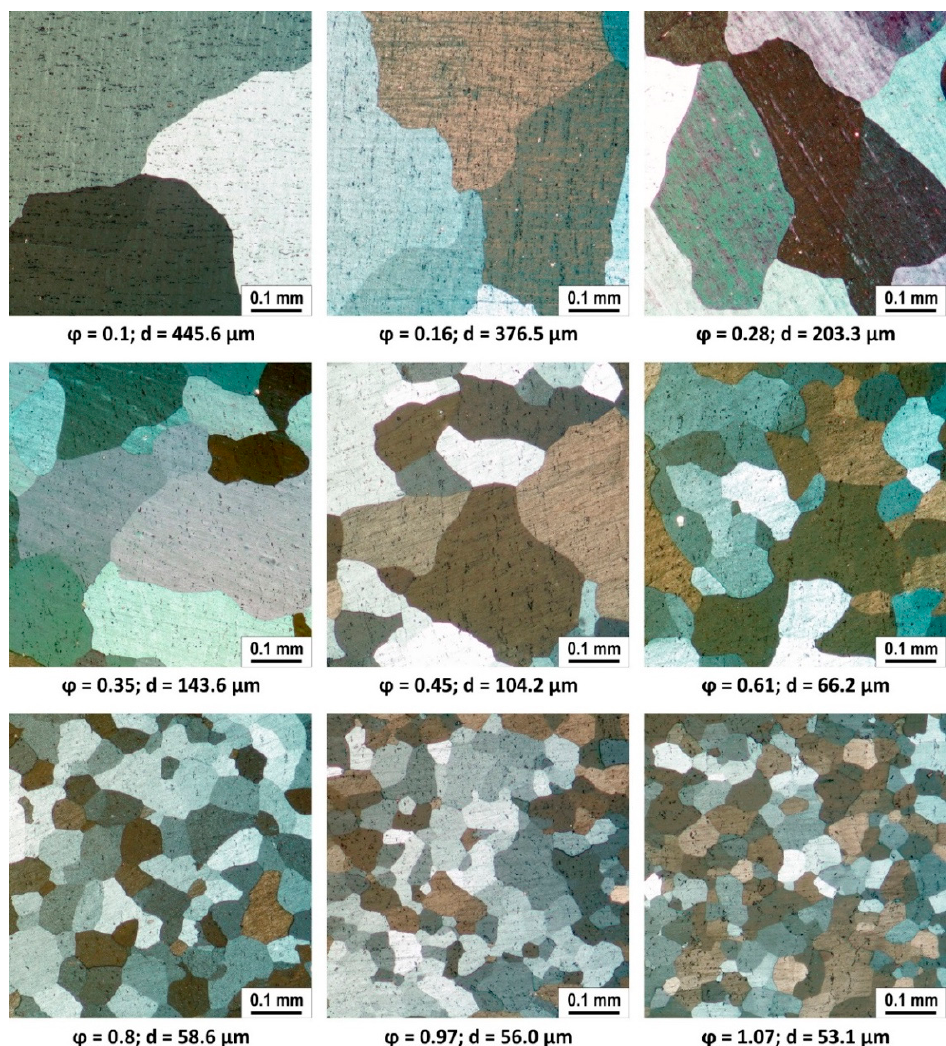
Figure 6. Grain size microstructure for different strains φ (polarized LM).